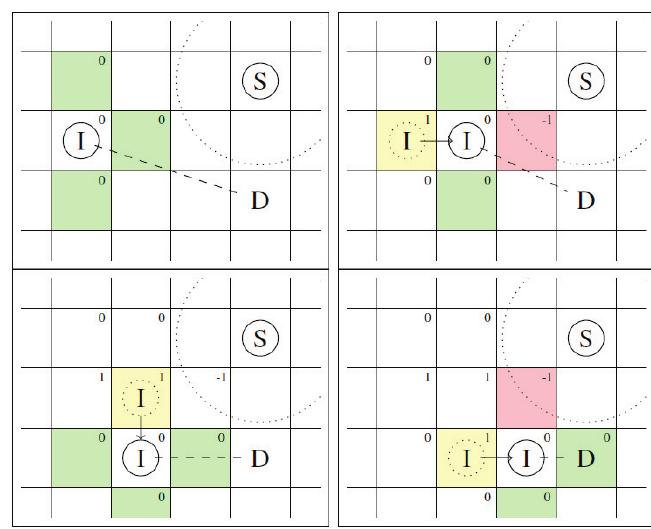
Figure 3. An illustration of the flood fill